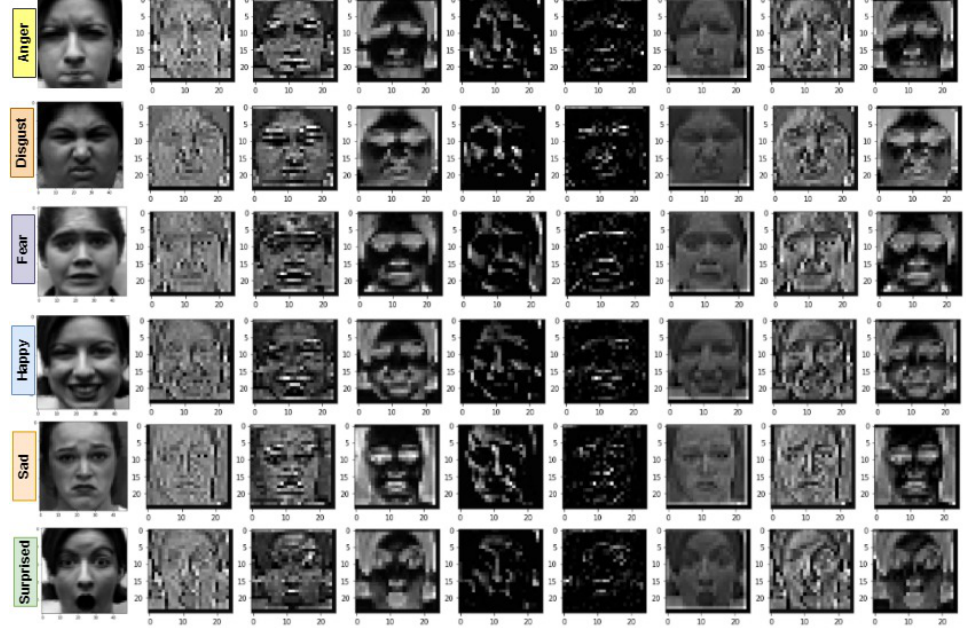
Figure 14. Feature Maps of few